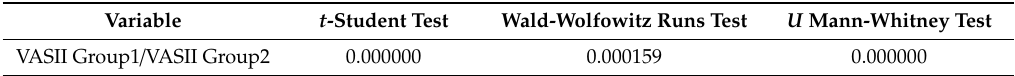
Table 14. Comparison of Group1 and Group2 after 14 days.